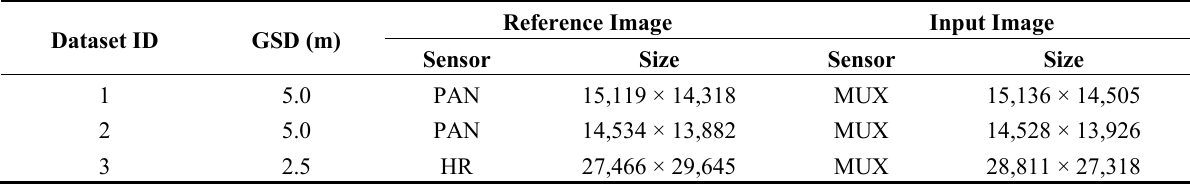
Table 2. Images after geometric